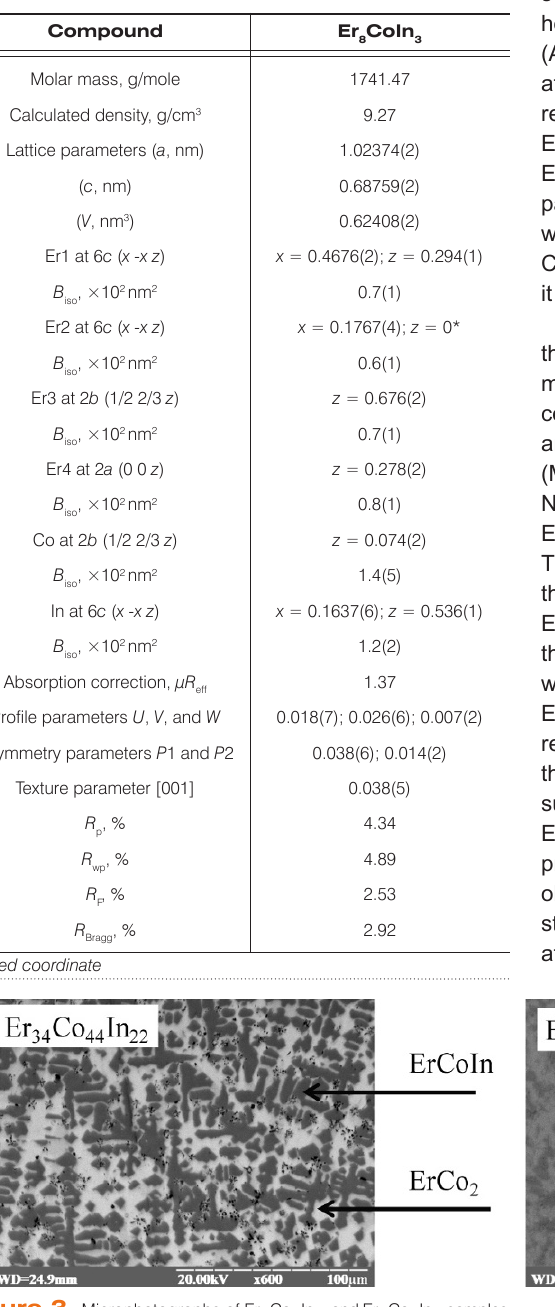
CoIn compound. 8 3